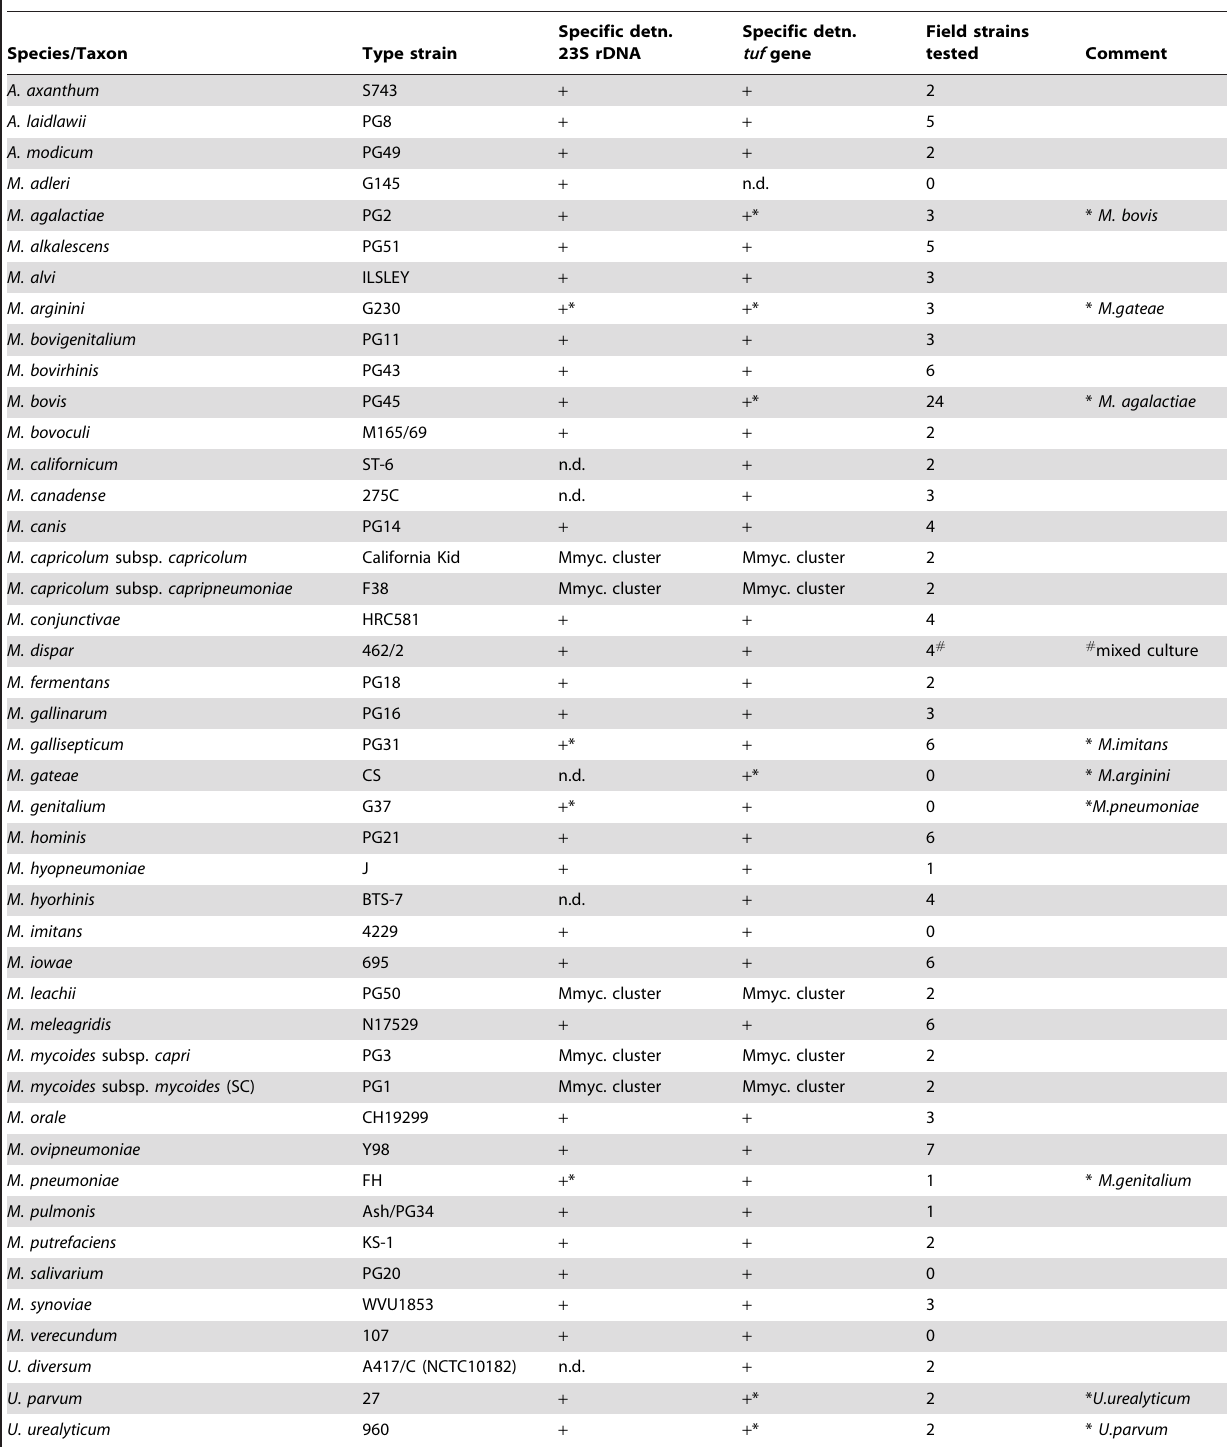
Table 1. Summary of hybridization test results of 44 Mollicutes organisms on two genomic target sites.